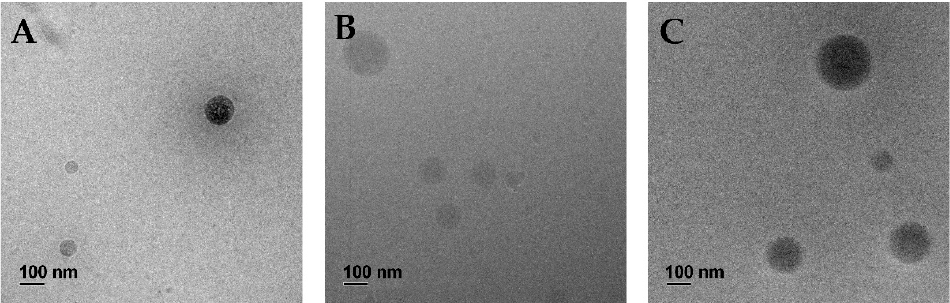
Figure 2. Cryo-TEM images of plain lipid–polymer nanoparticles: ( A ) DOTMA-PLGA-LPN (LPN(0/100)), ( B ) LPN(50/50), ( C ) DOPE-PLGA-LPN (LPN(100/0)). Images confirm spherical shape.